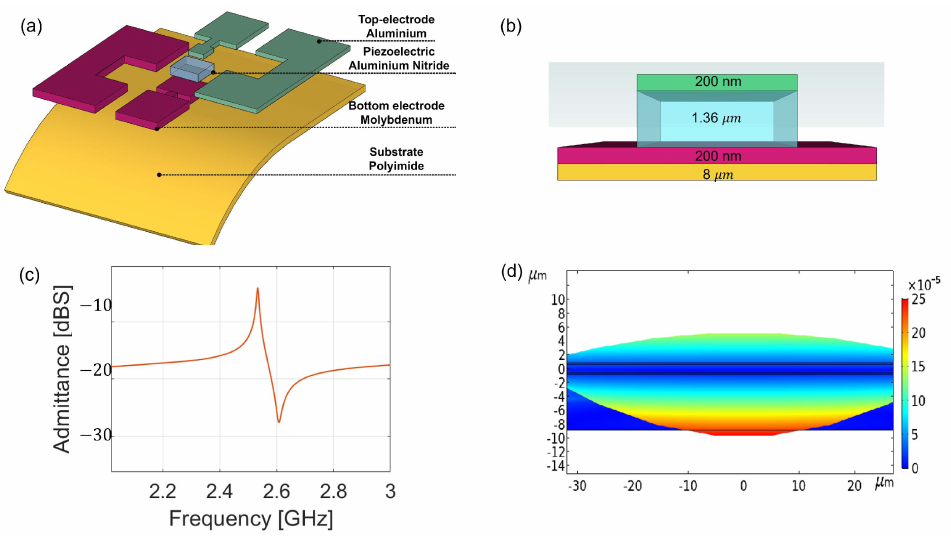
Figure 1. ( a ) Breakdown of the proposed device; ( b ) cross-section of the resonator; ( c ) simulated admittance; ( d ) modal shape of the mechanical travelling